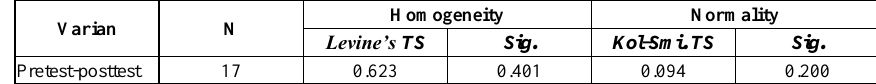
Table 1. The test result of homogeneity and normality